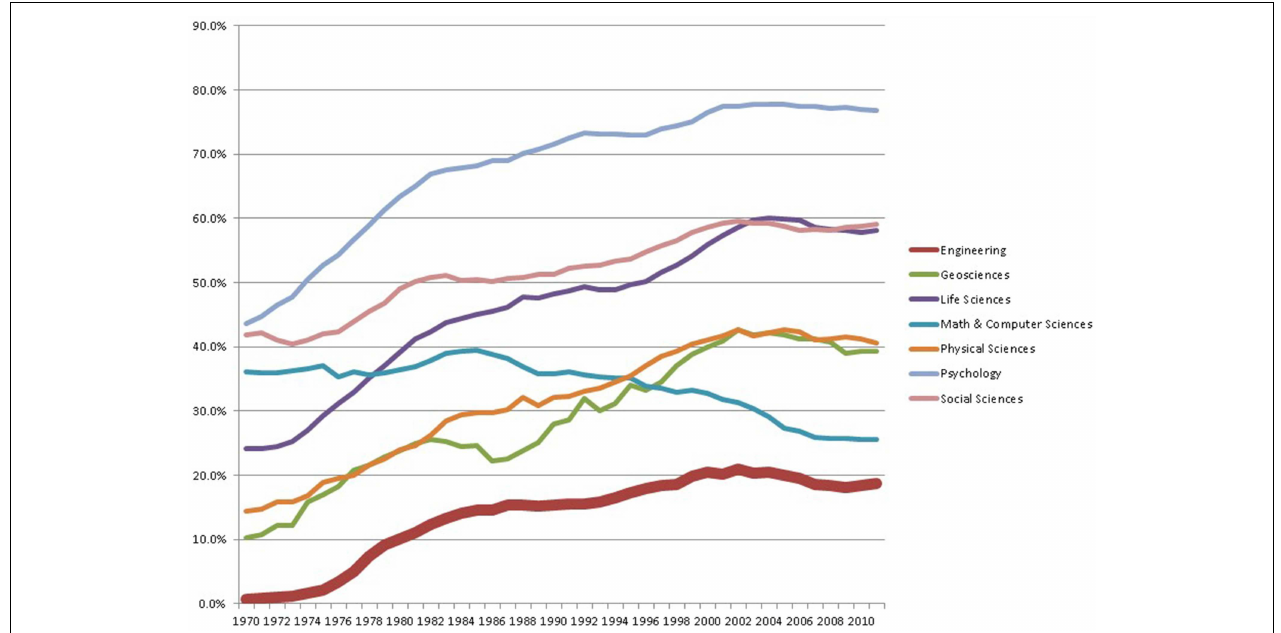
FIGURE 1 | Percent female among bachelors in engineering compared to other STEM fields over time. Data Source: NSF WebCASPAR data base